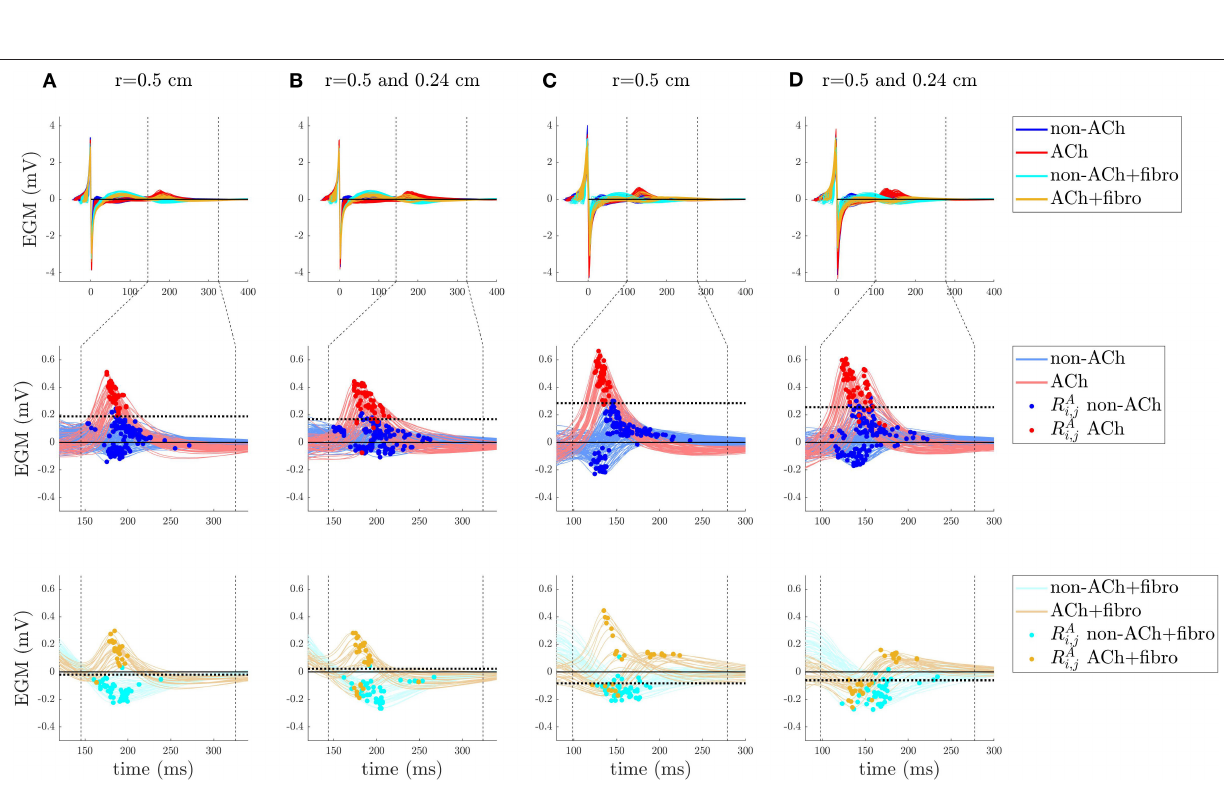
Frontiers in Physiology |